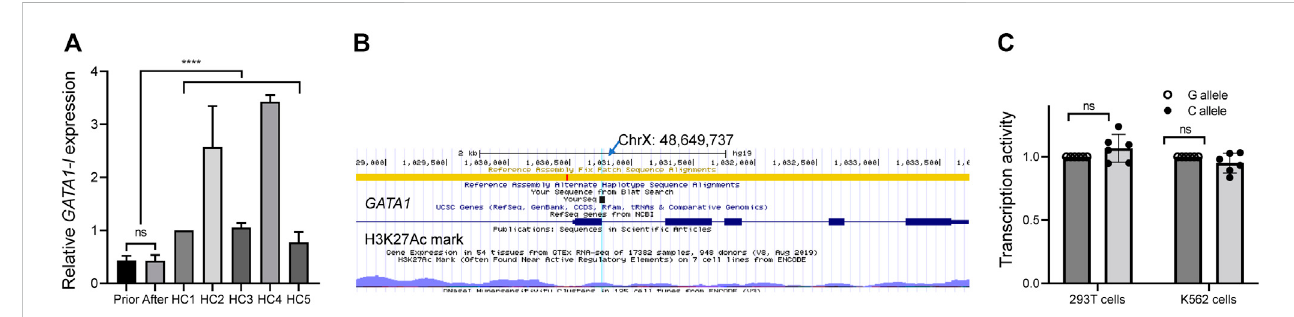
FIGURE 2 Functional assay of de novo GATA1 mutation. (A) mRNA level of long GATA1 isoform in peripheral blood mononuclear cells from the patient before and aftertherapy,aswellasfromhealthycontrolsubjects(HC),**** p < 0.0001. (B) Referencenucleotidefromtheepigenomebrowser.Thearrowshowsthepoint of mutation according to the sequence result. (C) A luciferase reporter assay showed that GATA1 (C) 220 + 1G > C mutation did not impair the transcriptional activity in 293T cells and K562 cells. Data represent the mean ± standard deviation (SD), ns, no signi fi cance.